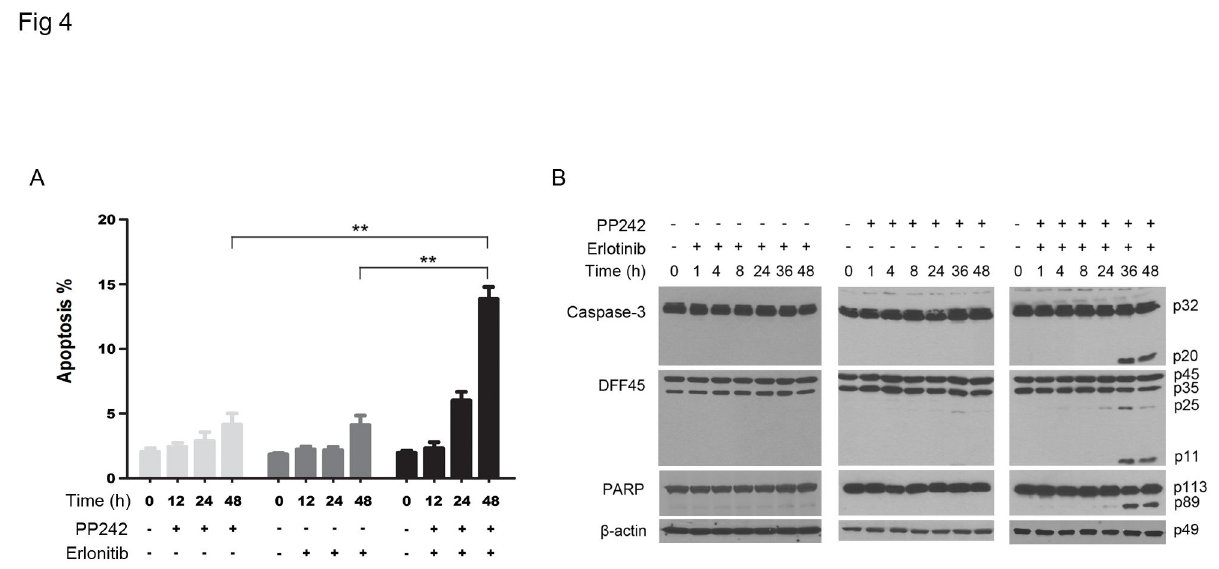
Figure 4. PP242 and erlotinib treatment induce apoptotic cell death. (A) DLD-1 cells were treated with erlotinib (2 μM) and PP242 (1 μM), alone or in combination, for the indicated hours and then analyzed by flow cytometry. The percentage of sub-G1 apoptotic cells were presented as mean + SD. **, p < 0.01. (B) DLD-1 cells were treated with PP242 (1 μM) and/or erlotinib (2 μM) for the indicated hours and analyzed by western blotting for the cleavage of caspase-3, DFF45 and PARP with the molecular weights of the cleavage products indicated to the right of the panel. doi: